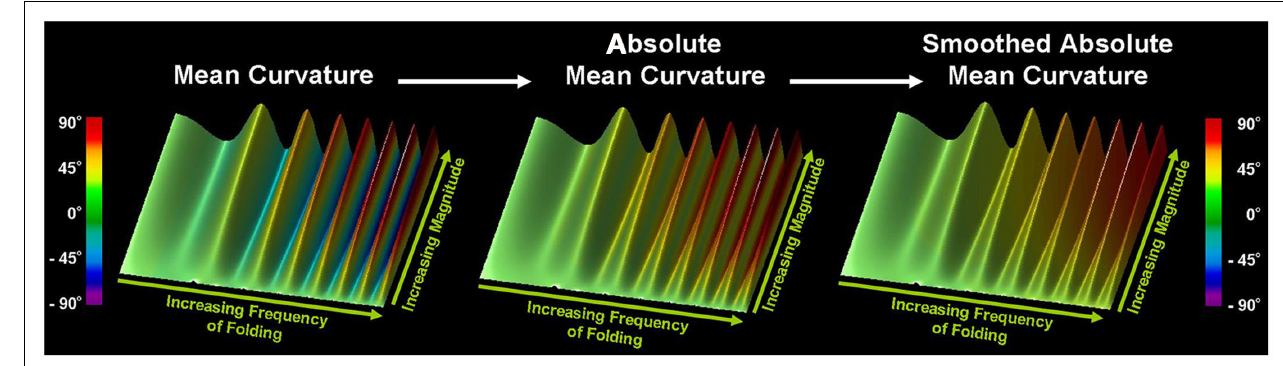
distances of 3mm, values are transformed into absolute mean curvature (i.e., all values become positive regardless of whether they represent gyri or sulci). Higher values indicate areas with larger gyrification. Right Panel: Curvature values are smoothed using a surface-based heat kernel filter with FWHM = 25mm. As demonstrated, increases in the amplitude and wavelength of the simulated folding are reflected in increased values of smoothed absolute mean curvature